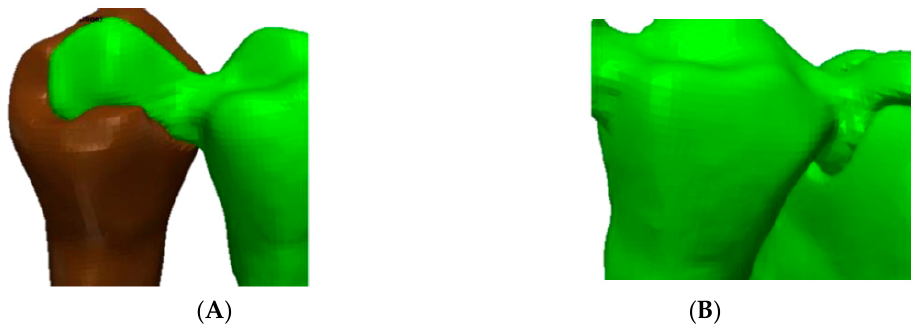
Figure 4. Connectors used in this study: ( A ) mesial connector; ( B ) distal connector.